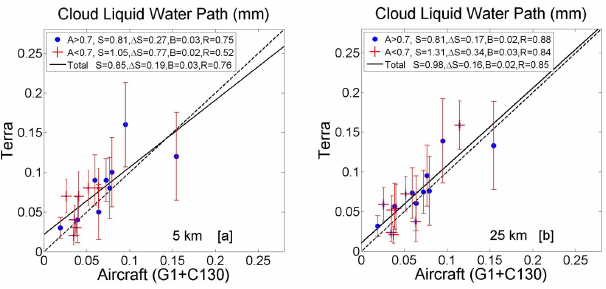
Fig. 7. Comparison of cloud liquid water path derived from MODIS with in-situ